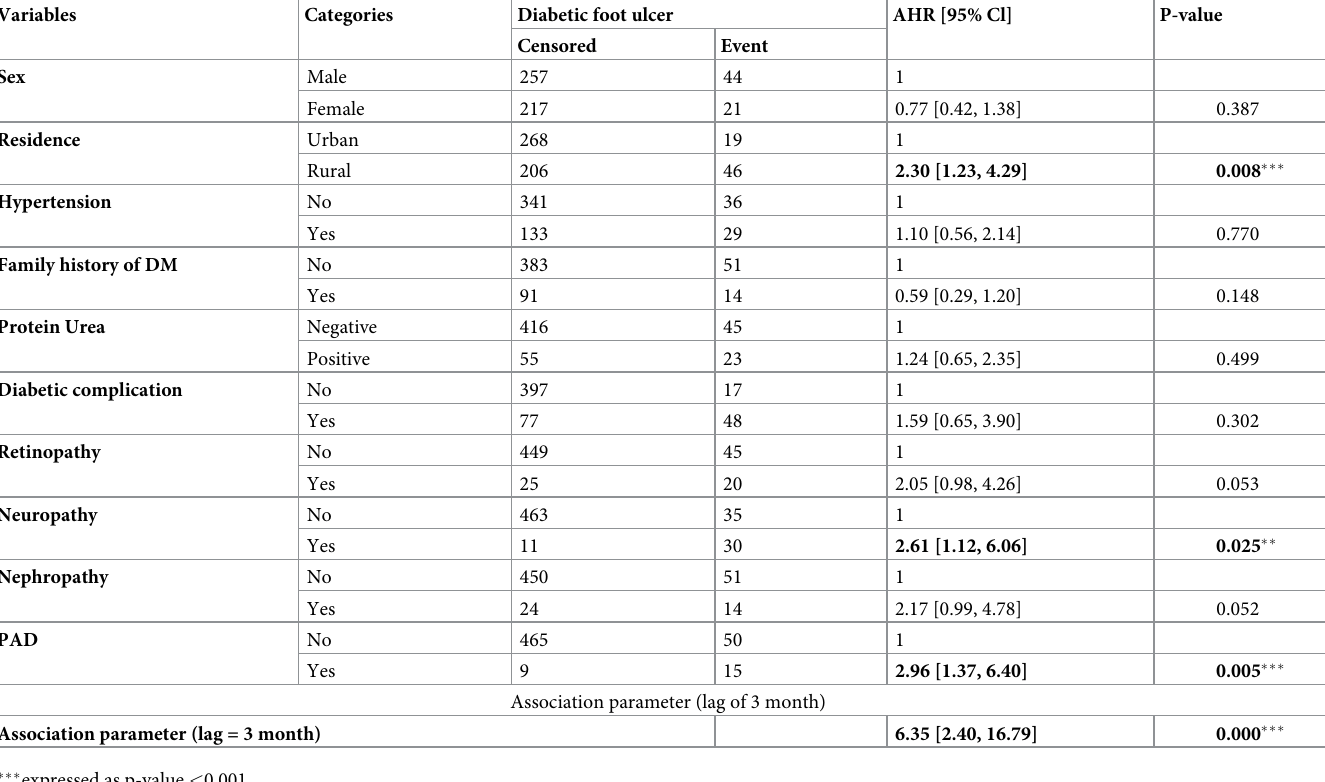
Table 3. Joint model (Survival sub models with time dependent association parameters) for DM patients on treatment in Northwest Ethiopia, 2010 to